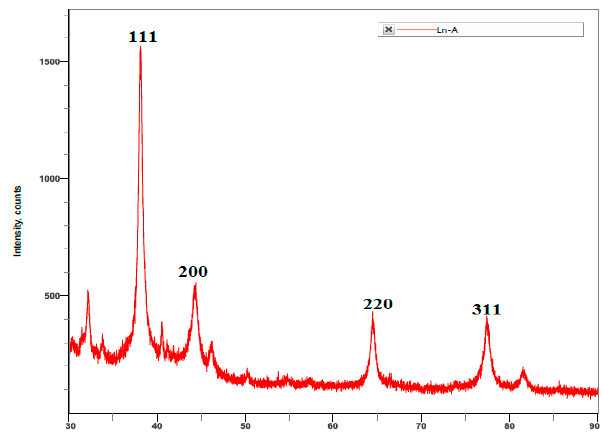
Figure 5. XRD spectra of biosynthesized LnFb-AgNPs from L. nepetifolia flower bud extract.